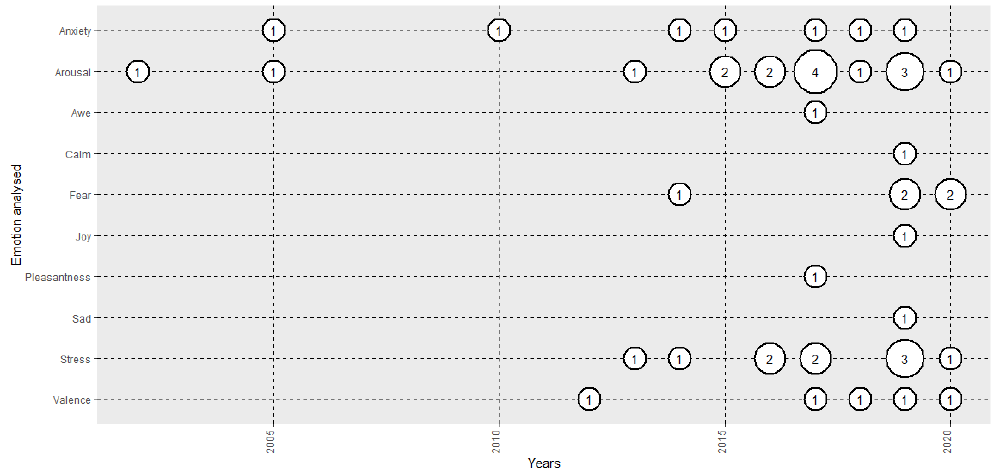
Figure 3. Evolution of the number of papers published each year based on emotion analysed.